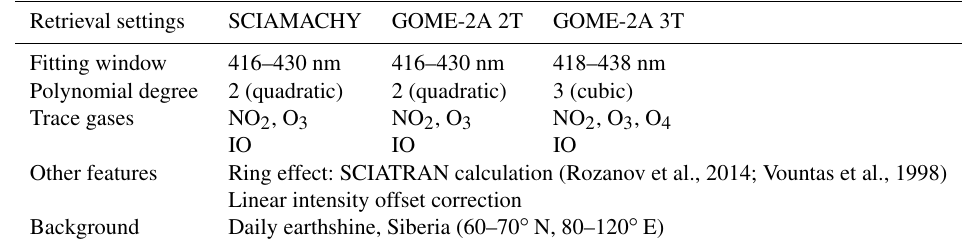
Table 1. Retrieval settings for IO from SCIAMACHY and GOME-2A